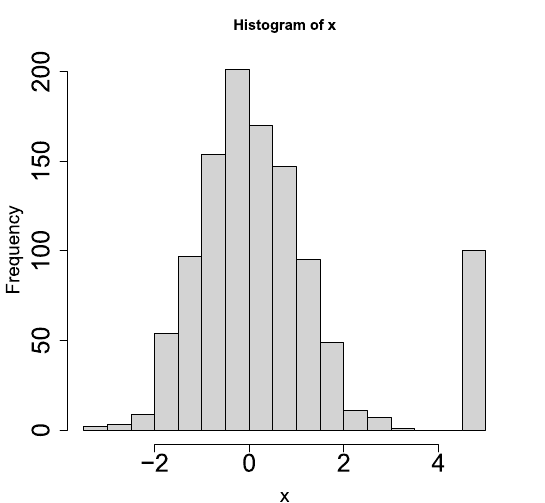
Figure 4. A histogram of Gaussian distribution with